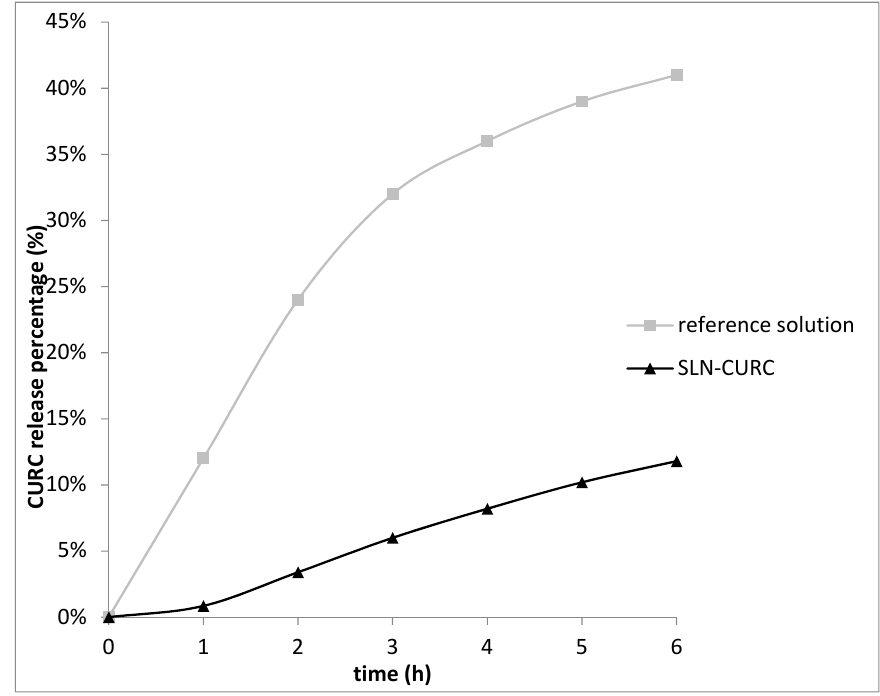
Figure 5. CURC release from SLN-CURC compared to reference solution (up to 6 h).